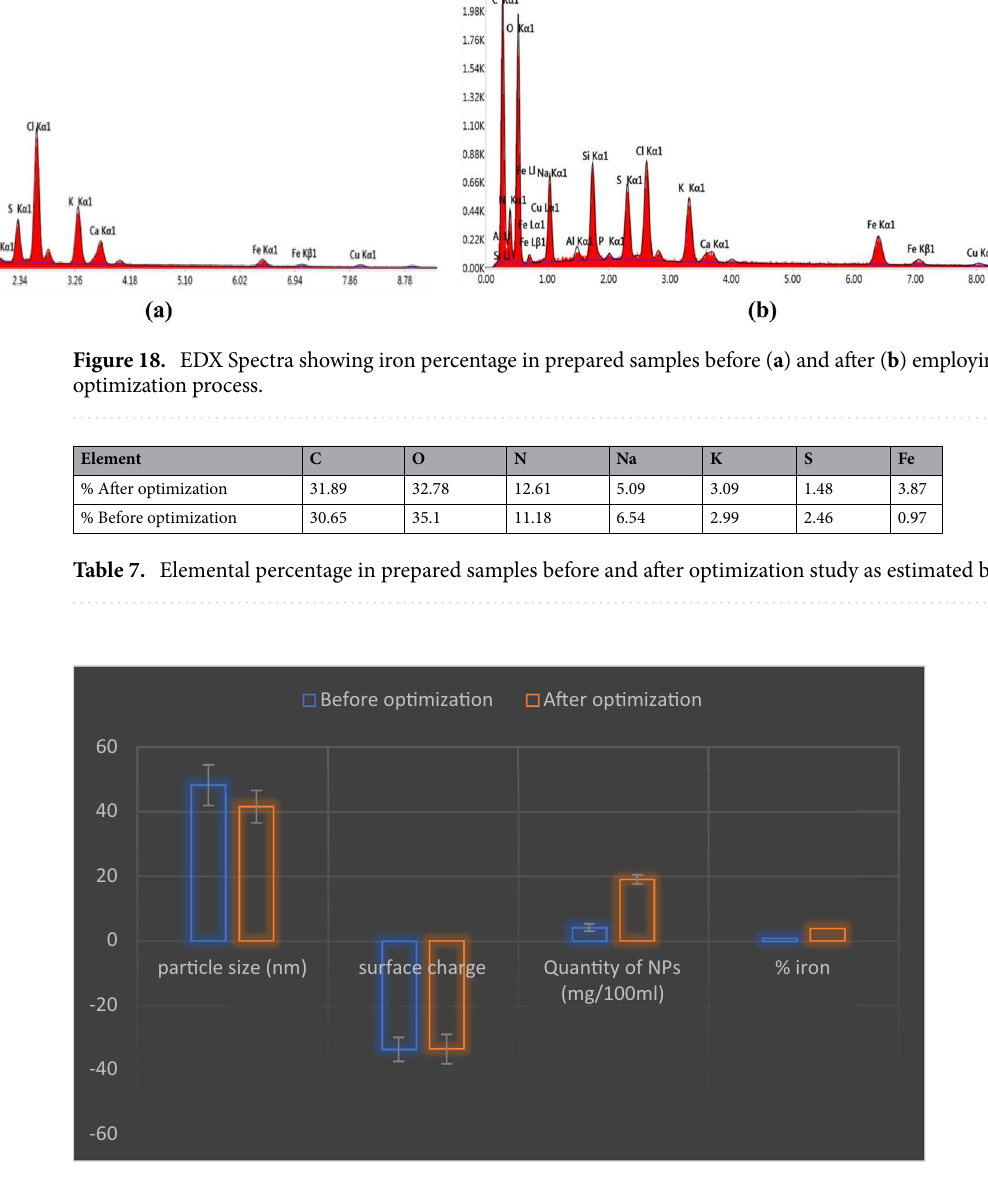
Figure 19. Effect of optimization process on characters and quantity of produced iron